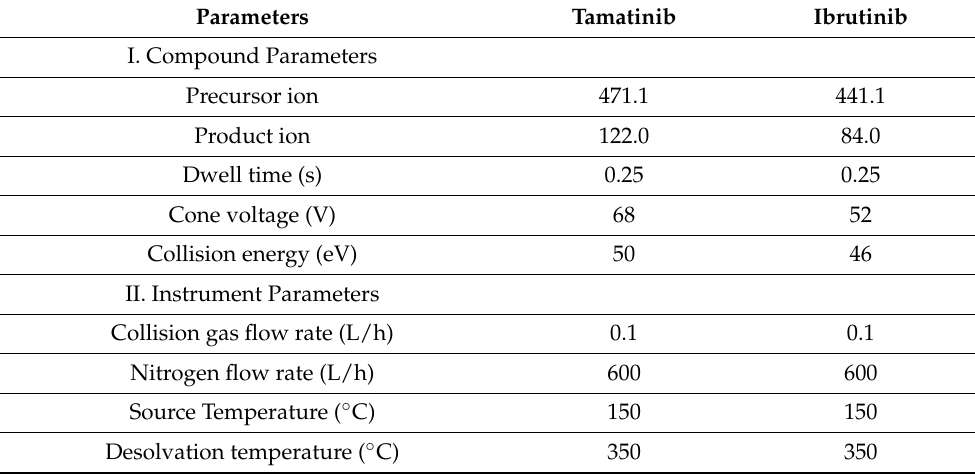
Figure 7. Chemical Structure of Fostamatinib ( A ), Tamatinib ( B ), and Ibrutinib ( C ). Table 7. Mass Optimization Parameters for Tamatinib and Ibrutinib